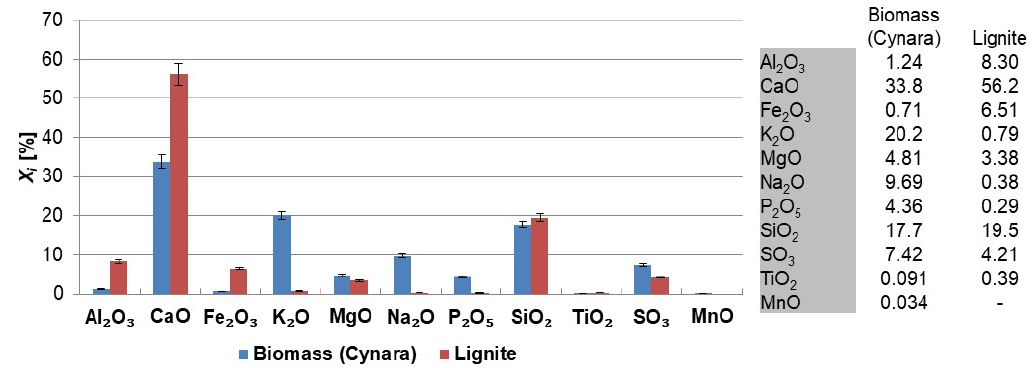
Figure 3. Major and minor oxides of the herbaceous biomass ( Cynara ) and Greek lignite.